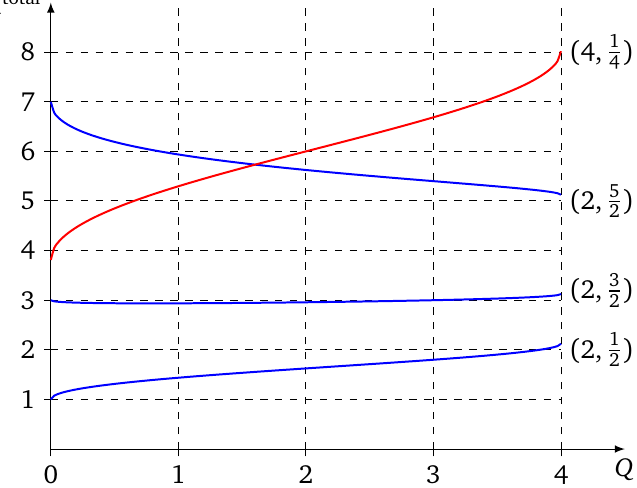
Figure 2.2: Conformal dimensions of low-lying states in the odd spin sector of the Potts model, as functions of Q . We use blue for states that belong to the odd CFT, ) that does and red for the state ( 4, 1 4